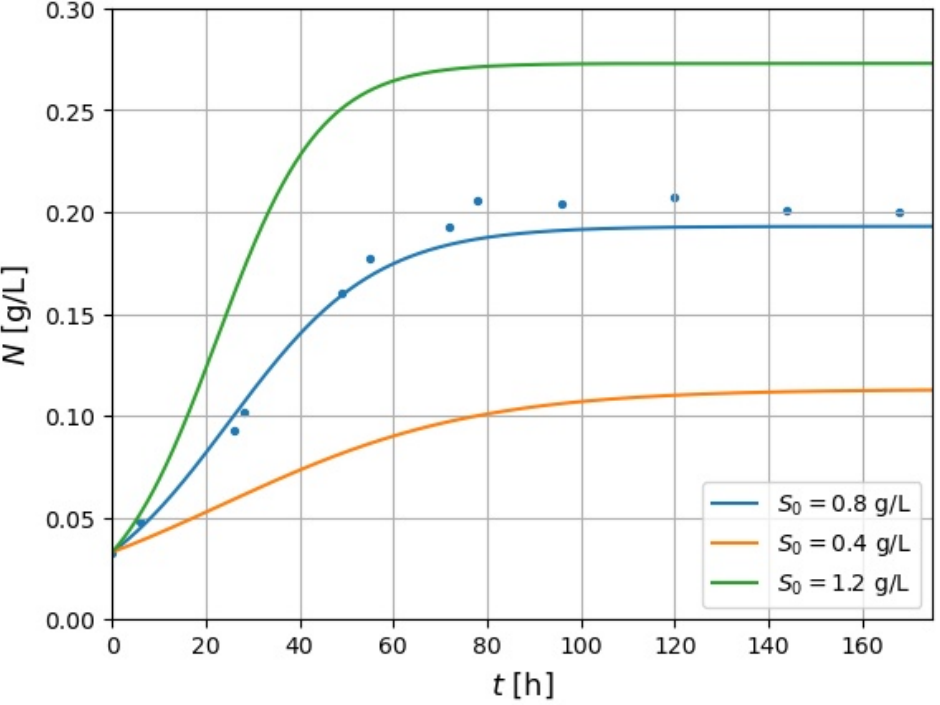
Figure 4. Dependence of bacteria concentration N ( t ) on different initial concentrations of nutrient source. All the independent parameters ( a = 60 g/L, r m = 4 h − 1 and γ = 0.2, and N o = 0.033 g/L). Blue dots correspond to the experimental data.